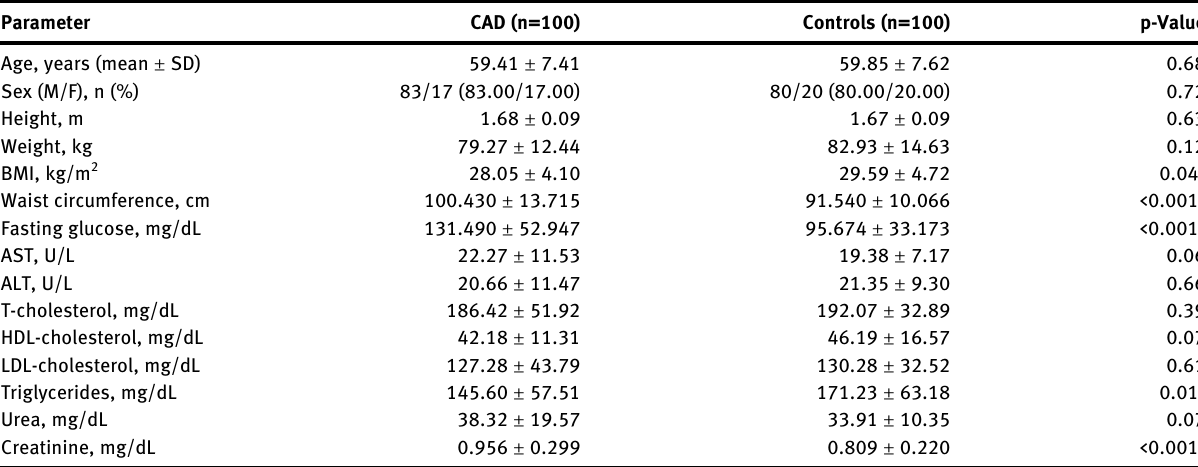
Table  : Clinical and demographic characteristics of CAD patients and controls. Parameter